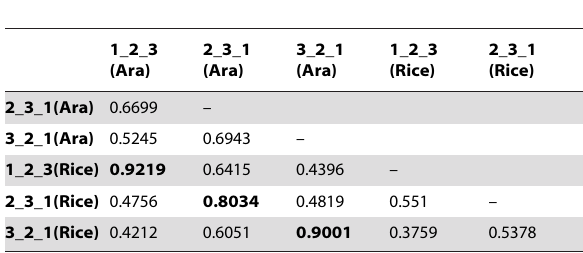
Table 6. Trinucleotide biases correlations between Arabidopsis thaliana and Oryza sativa (p , 0.01).